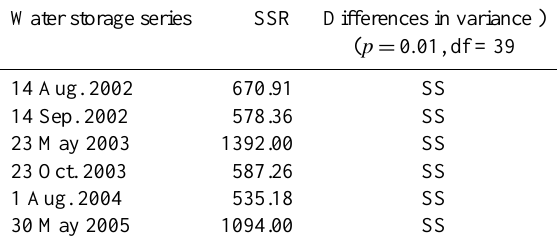
Table 2. Sum or Squared difference of Residuals between the τ ( q) of the data and the simulated monofractal type distribution using UM model for the soil water storage of six observation